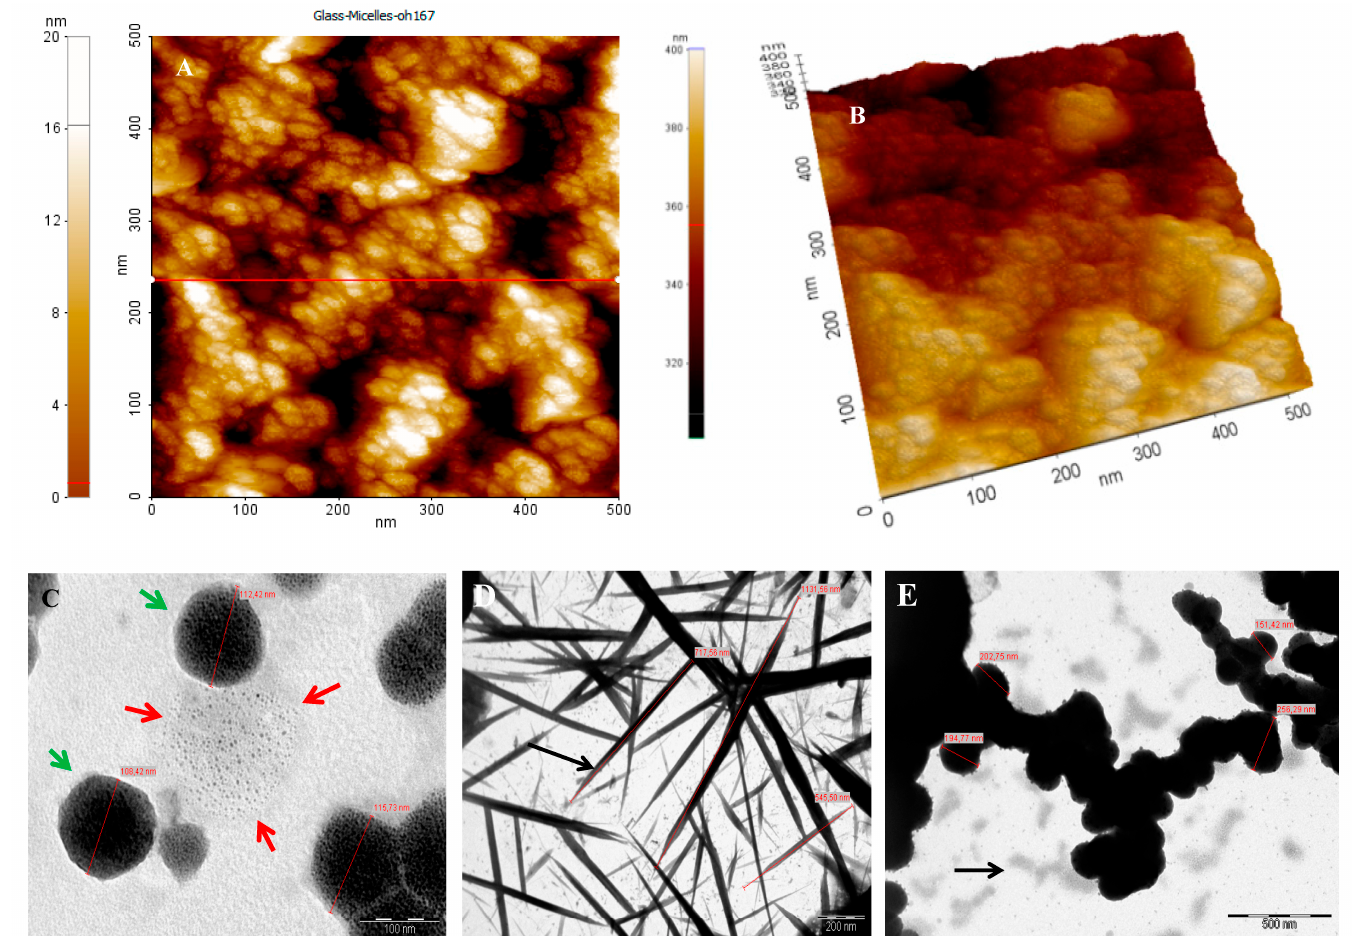
Figure 3. Characterization of nano-micelles. ( A ) Topographical Atomic Force Microscopy (AFM) image of nano-micelles; ( B ) AFM 3D visualization of nano-micelles; ( C ) High magnification Transmission Electron Microscopy (TEM) image of details of nano-micelles; ( D ) TEM image of extended nano-micelles; ( E ) TEM image of shrunk nano-micelles.